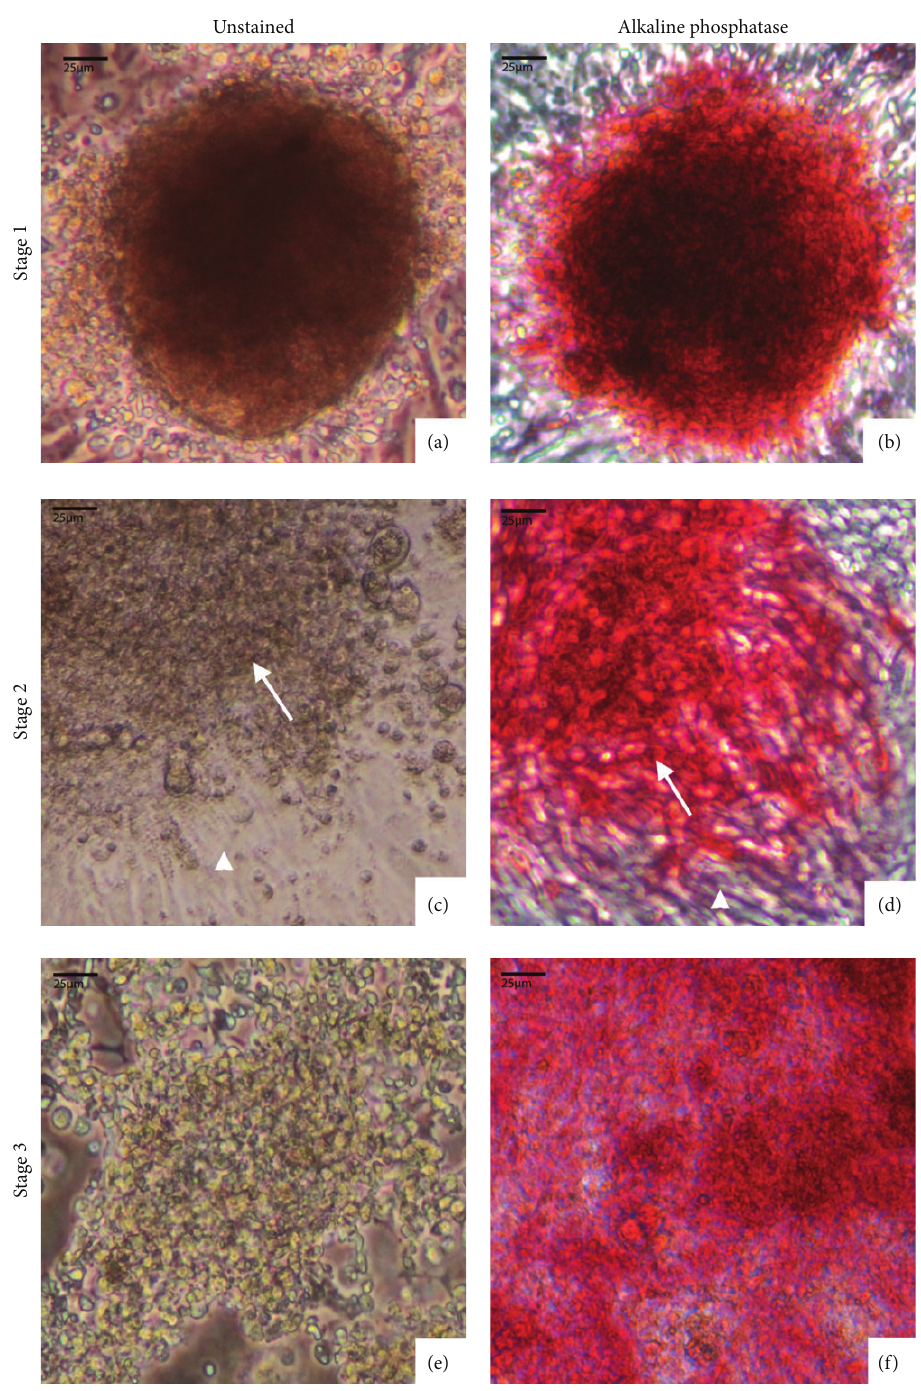
Figure 2: Three stages of chicken iPSC-like cells morphological development in modified 2i+ media. (a) Stage 1: chicken iPSC-like cell colony during the 4th passage with a characteristic dark center. (b) Comparable colony as in (a) stained with alkaline phosphatase. (c) Stage 2: colony is lighter by the 8th passage with fibroblasts radiating from the stem cell colony. (d) Comparable colony as in (c) stained with alkaline phosphatase; the differentiated fibroblasts do not stain with alkaline phosphatase. Arrow, colony; arrowhead, fibroblast. (e) Stage 3: 10th passage, larger colony, and fewer fibroblasts underneath or on the sides. (f) Comparable colony as in (e) stained with alkaline